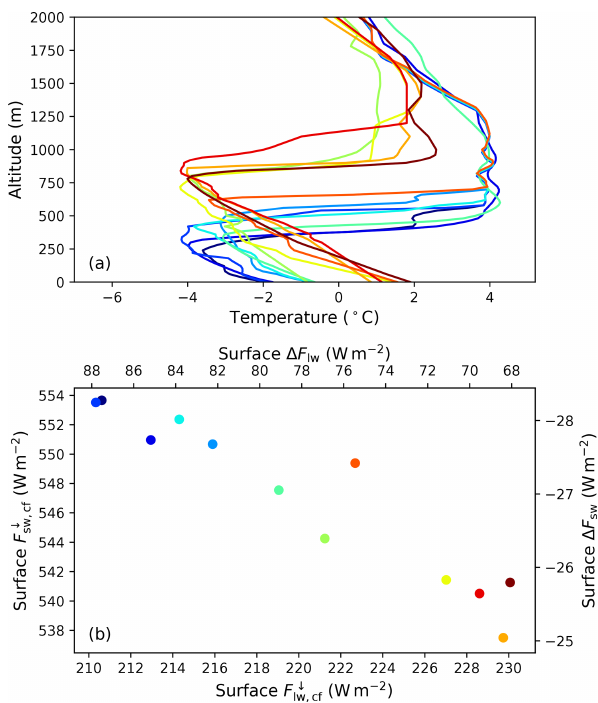
Figure 2. (a) Temperature profiles observed during the warm air in- trusion on 2 June 2017. The profiles are obtained from dropsonde and in situ measurements (merged with radiosoundings) and are color-coded by the air temperature in the lowest 200m. (b) Cor- relation between simulated cloud-free F observed atmospheric profiles from (a) (same color code). The sec- ond x and y axes show the expected longwave/shortwave CRF at the surface by assuming a constant F (298Wm − 2 ) based on observations. For a better comparability, the surface albedo and the SZA were fixed in the simulations to 0.8 and 60 ◦ ,